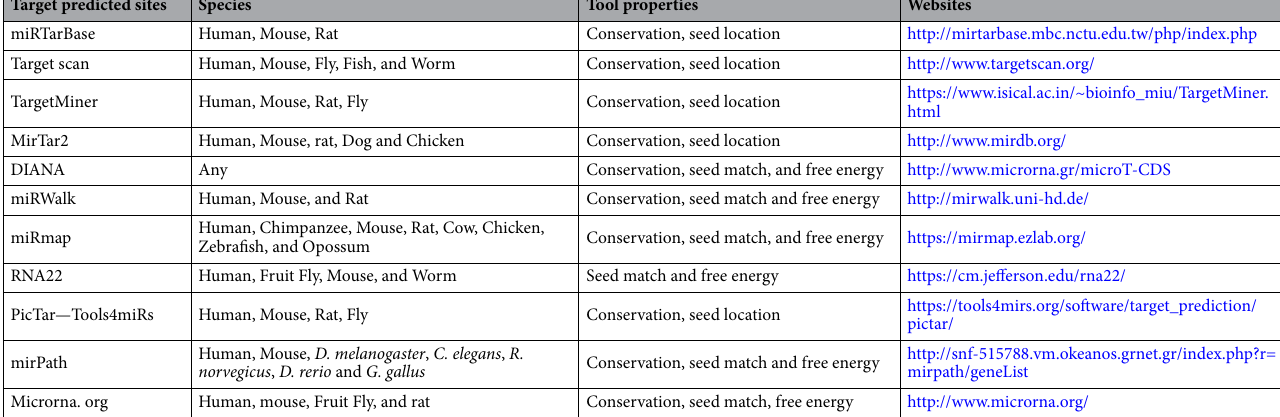
Table 4. Target predicted tools searched for identifying target predicted genes having complementary bases to miR-4510 seed